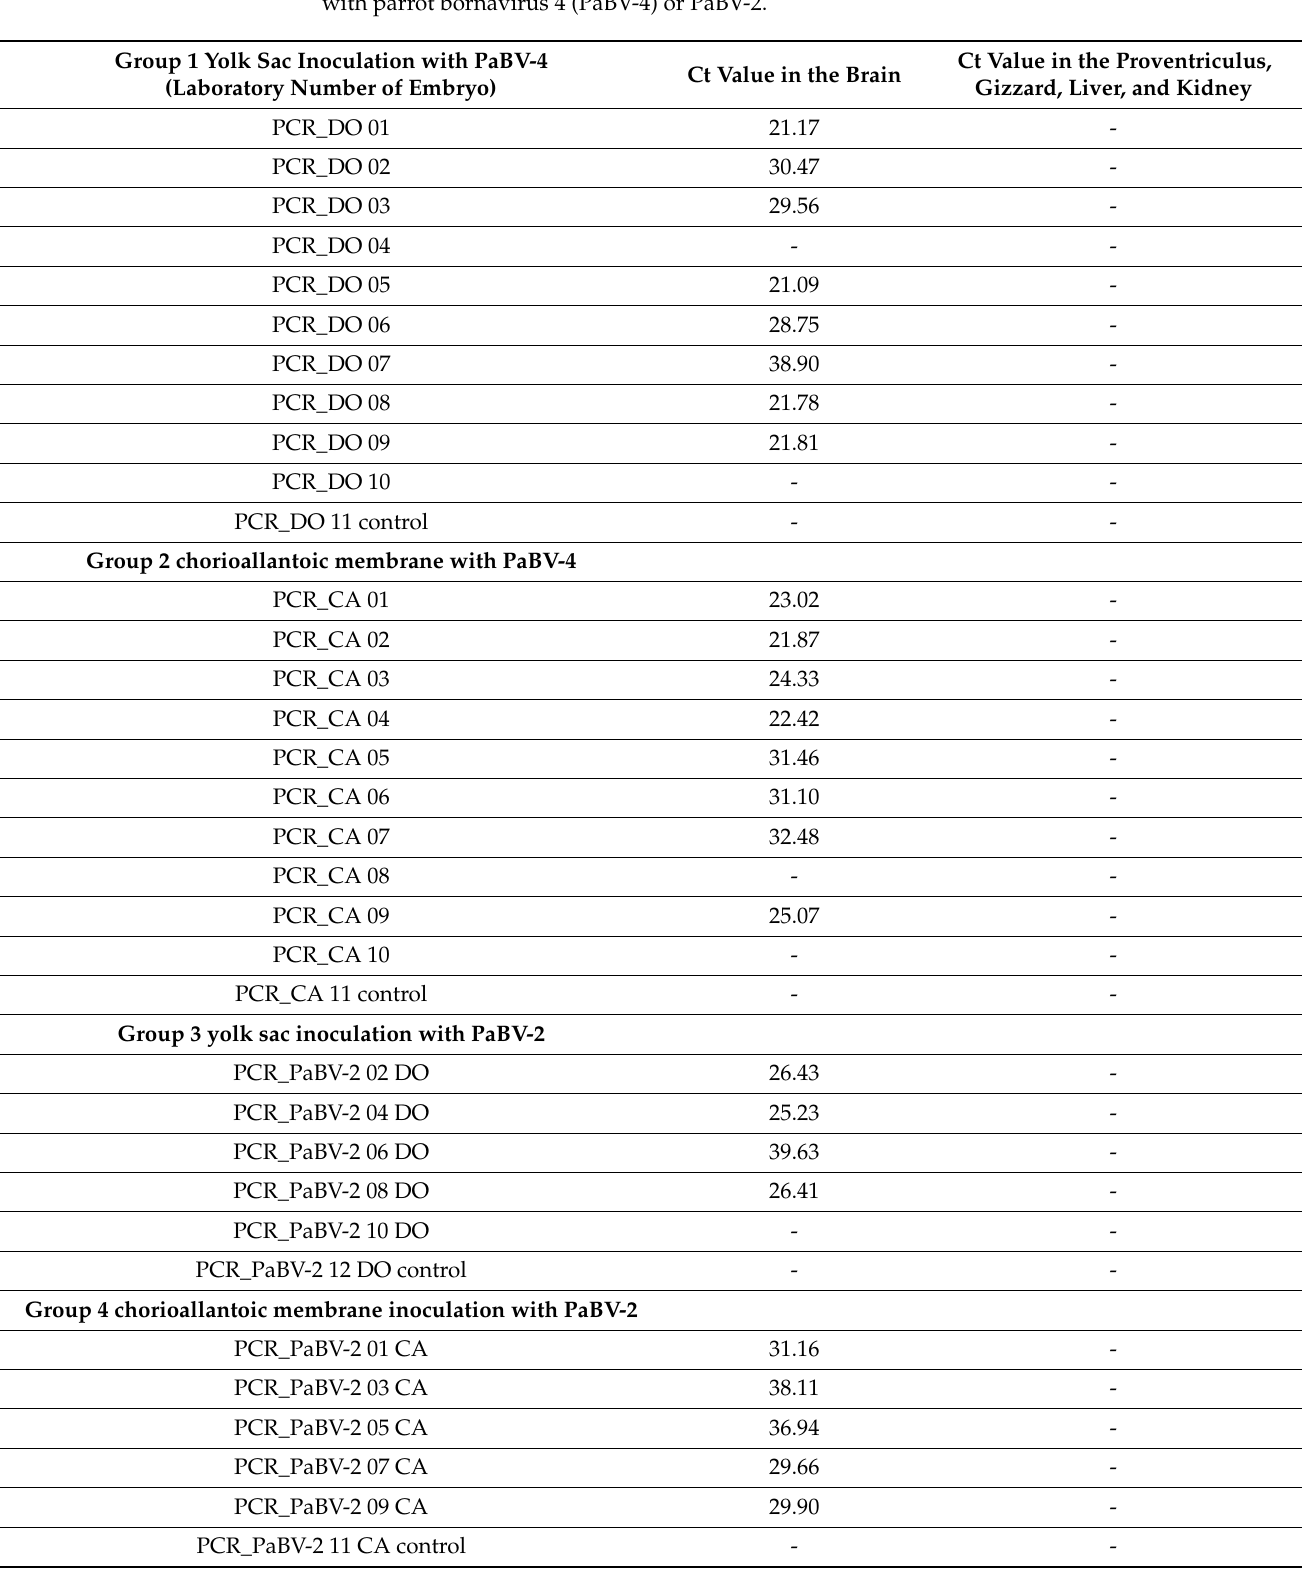
Table 2. Overview of PaBV RNA results for trial B yolk sac or chorioallantoic membrane inoculation with parrot bornavirus 4 (PaBV-4) or